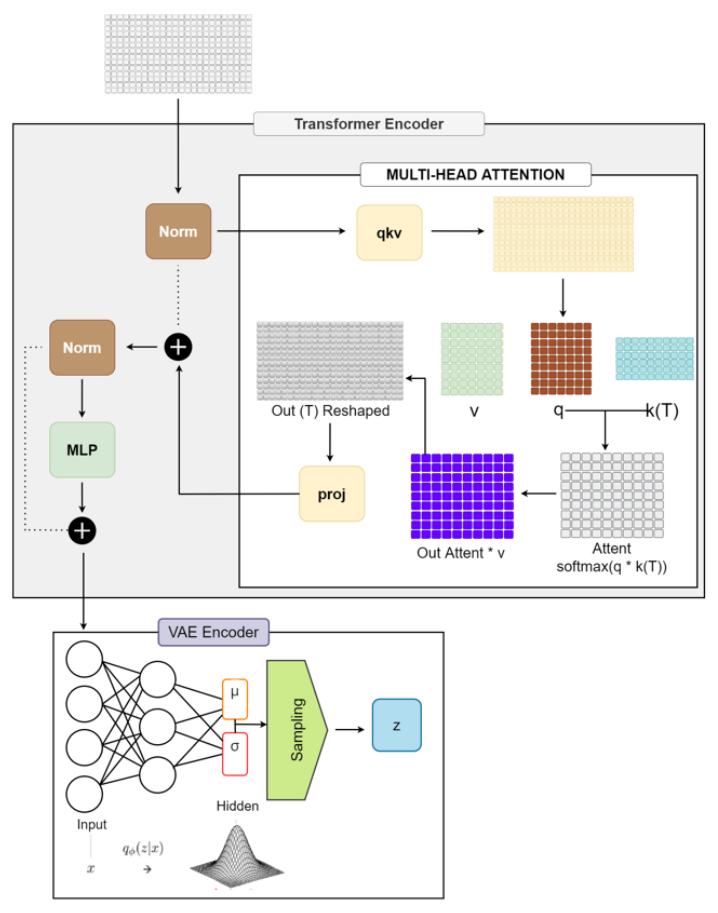
Figure 4. Data encoding with ViT and